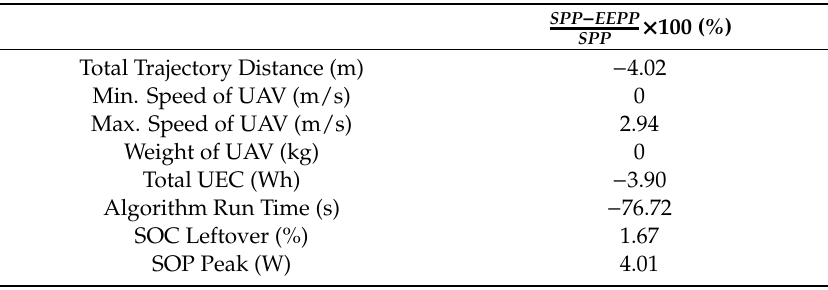
Figure 13. State of charge (SOC) and state of power (SOP) comparison (simulation): ( a ) SOC and ( b ) SOP. Table 3. Comparison results in percentage